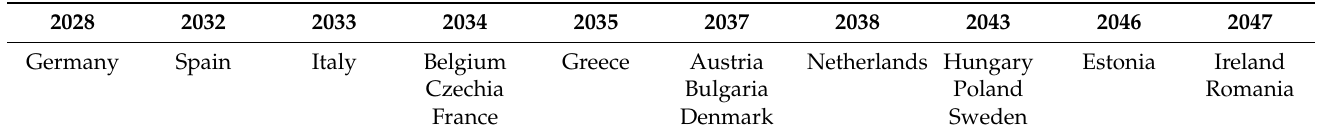
Table 8. Dates of achieving profitability criterion for PV waste recycling